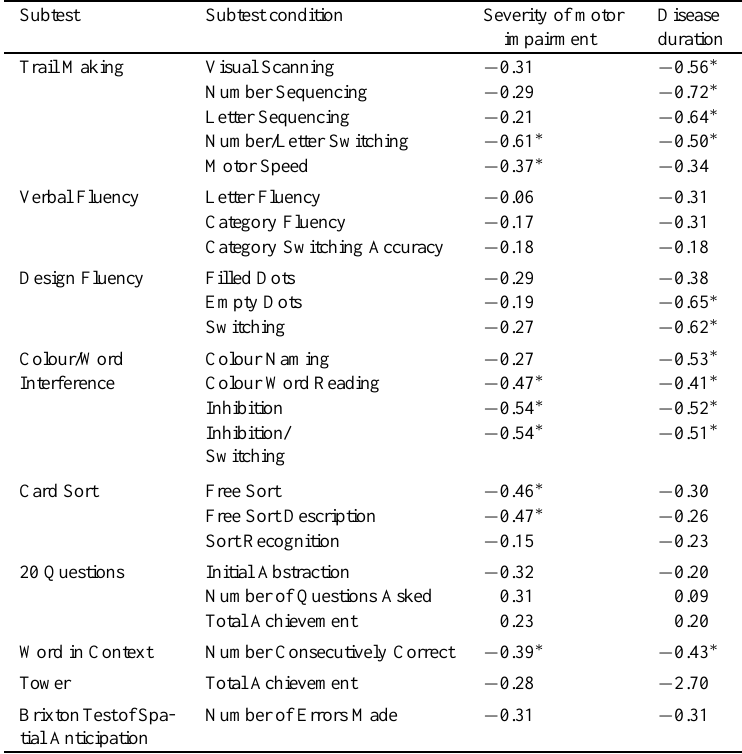
Table 7 Spearman’s rho correlations (one-tailed) between scores on tasks of executive